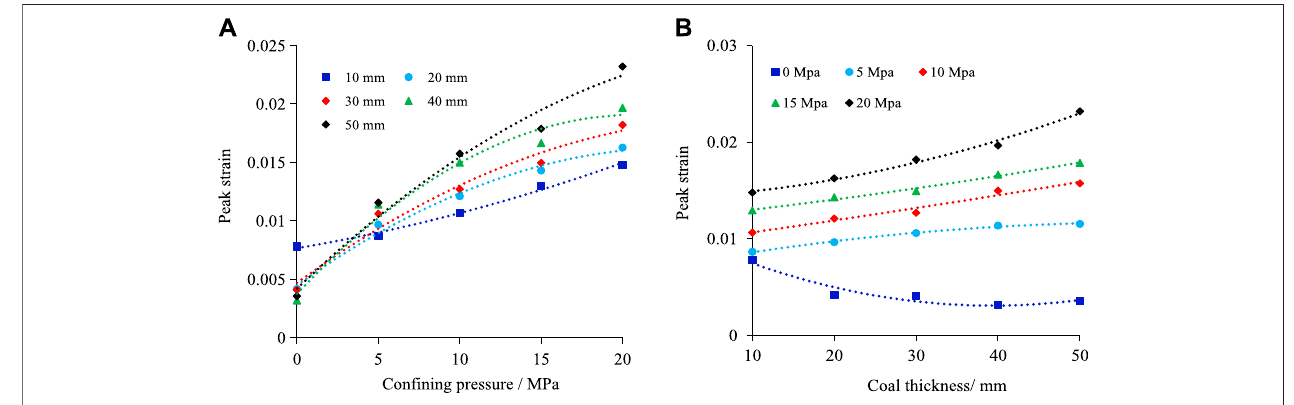
FIGURE 7 | Peak Strain of the RCR composites at different inclined coal seam thicknesses and different con fi ning pressures. (A) In fl uence of different con fi ning pressure; (B) In fl uence of different coal thickness.